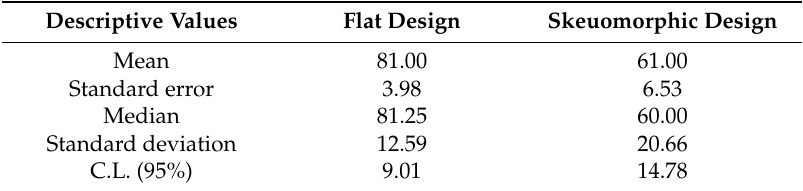
Table 13. SUS score descriptive